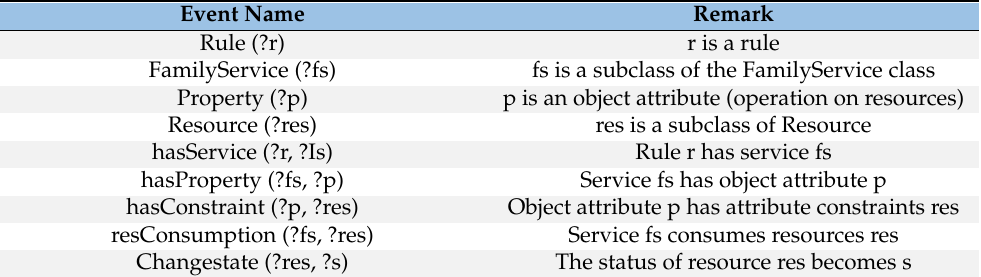
Table 1. List of air and sea coordinated assaults on the